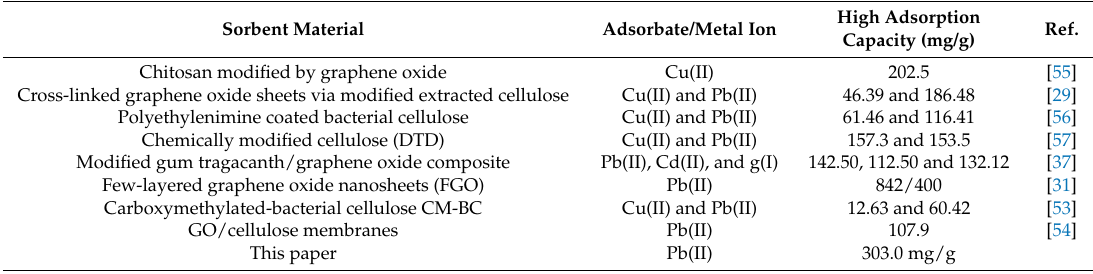
Table 4. This paper’s results when comparing different adsorbent materials reported recently in the